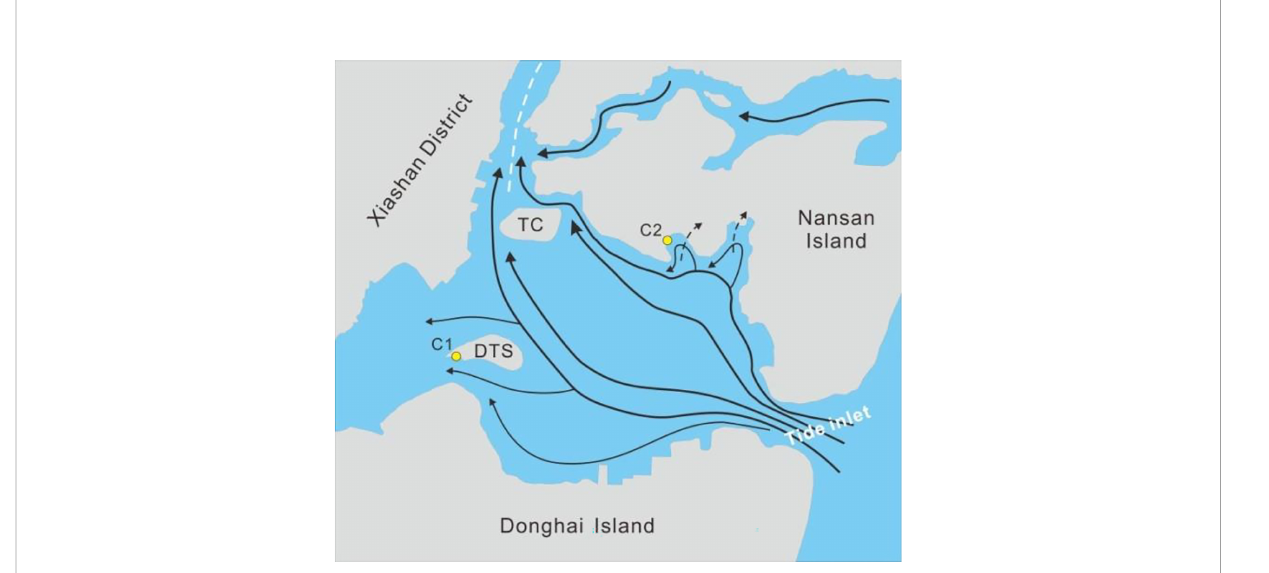
FIGURE 9 Map of modern tidal current distribution in Zhanjiang Bay.(White dotted line is the shipping lane of Zhanjiang port. Black dotted line is the tidal channel before the reclamation engineering. Thickness of the black lines represents the strength of the tidal